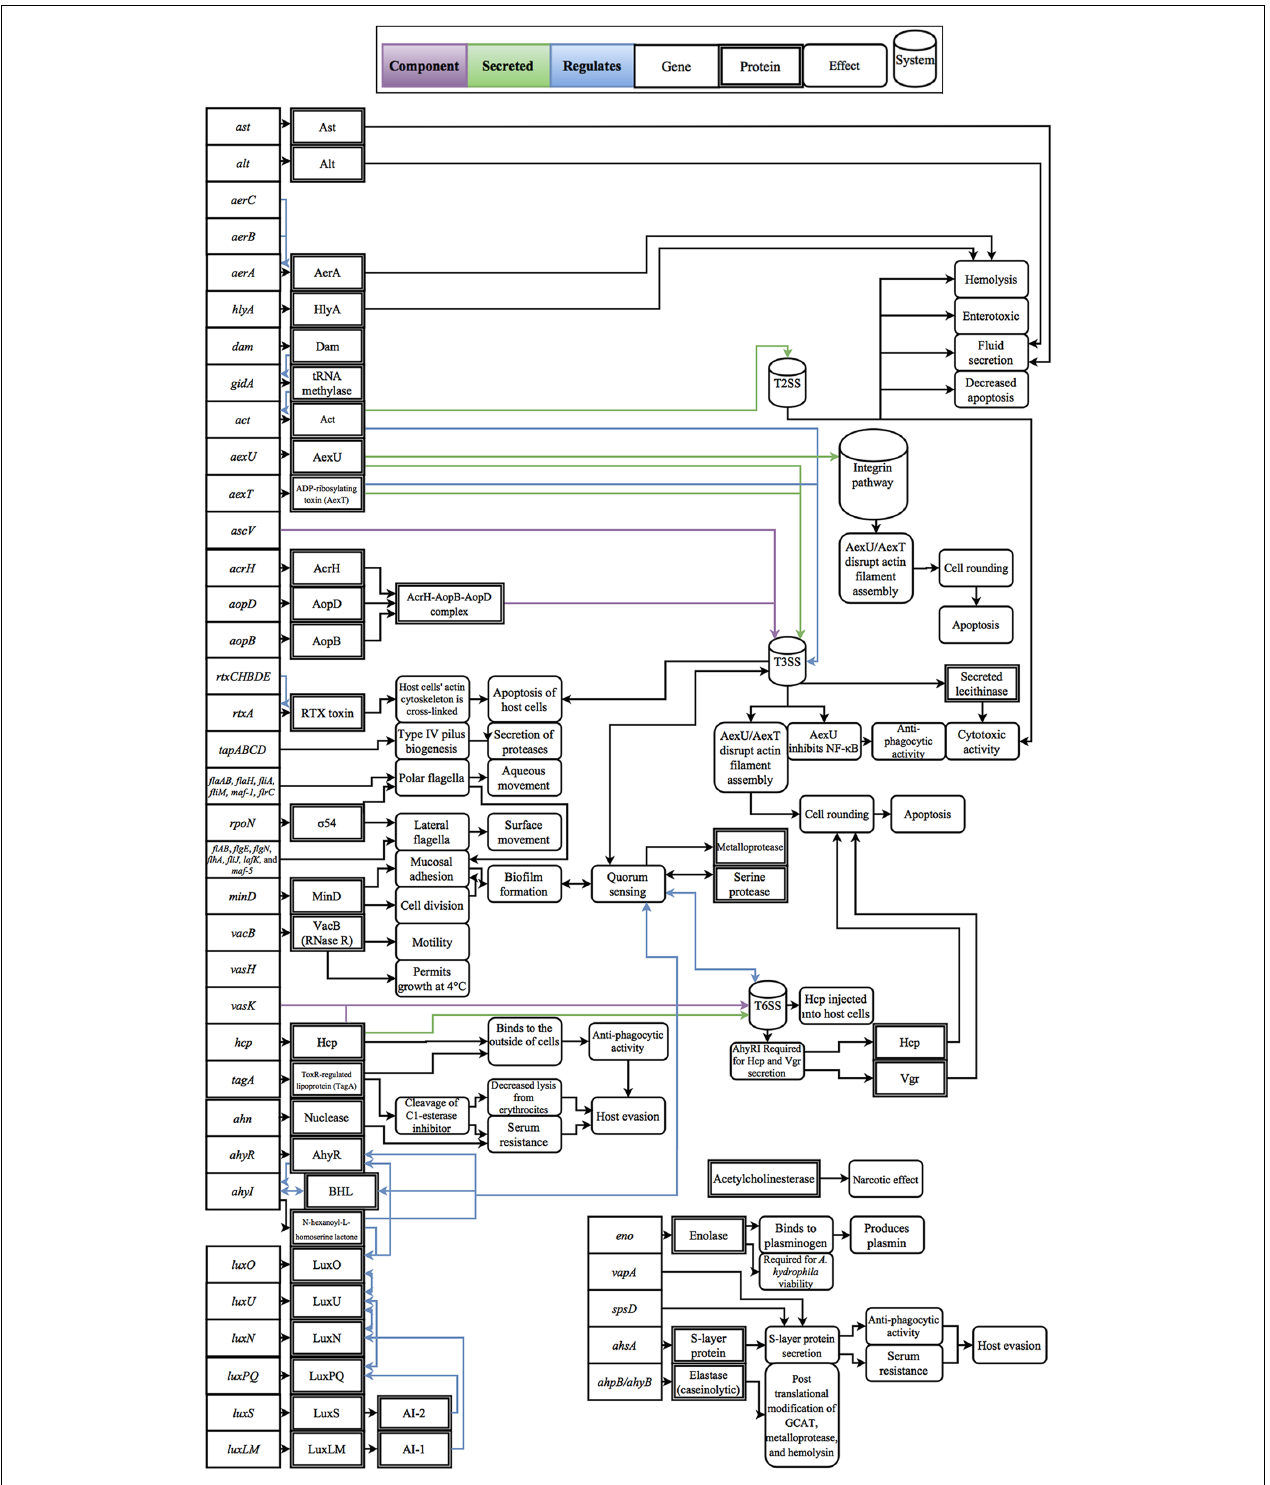
FIGURE 1 | Diagram of the gene products, molecular interactions and functions implicated in A. hydrophila virulence. These interactions are based on the collective literature referenced in this manuscript.